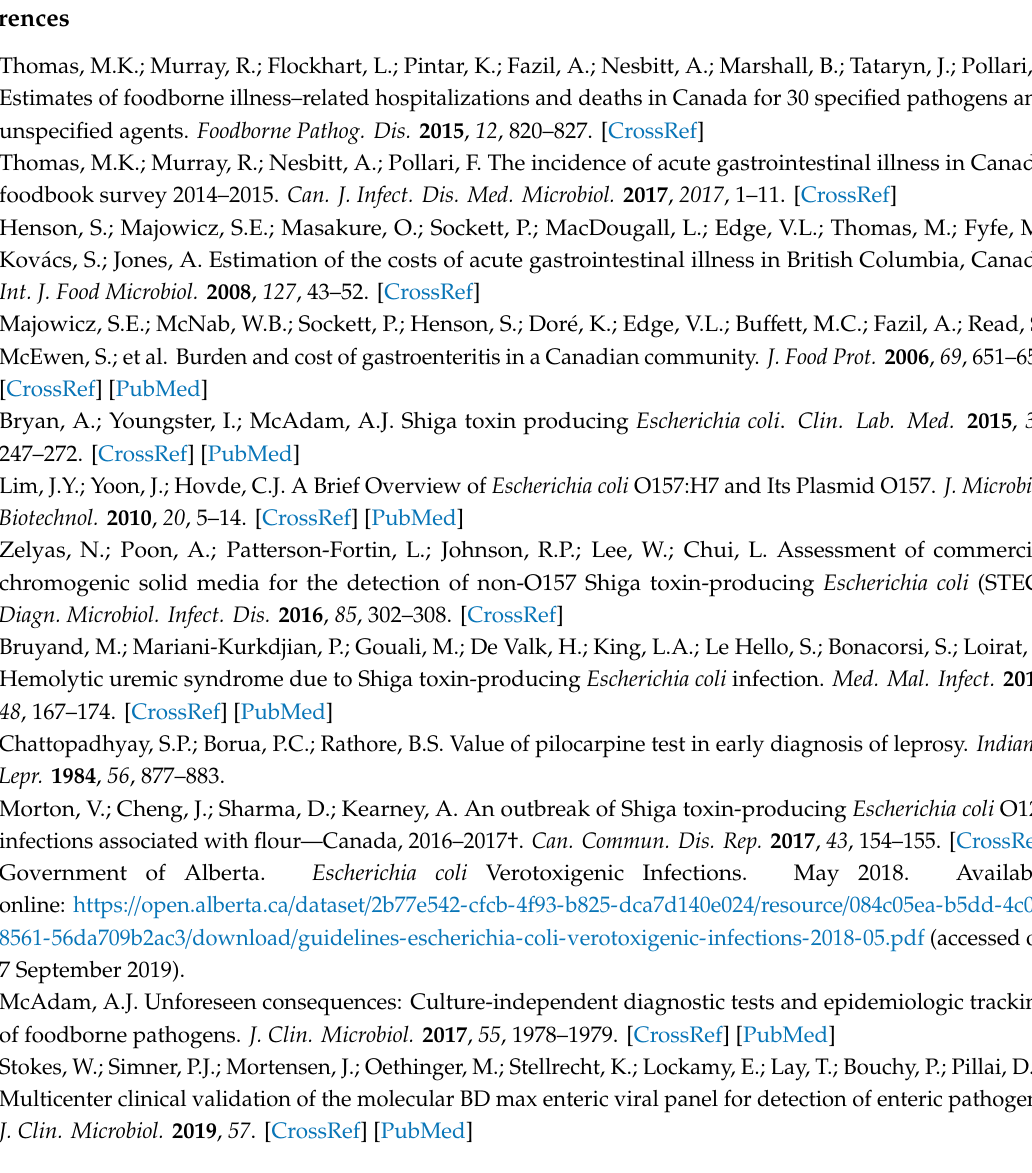
Table S1: Patient quadrant growth and corresponding averaged real-time PCR Ct